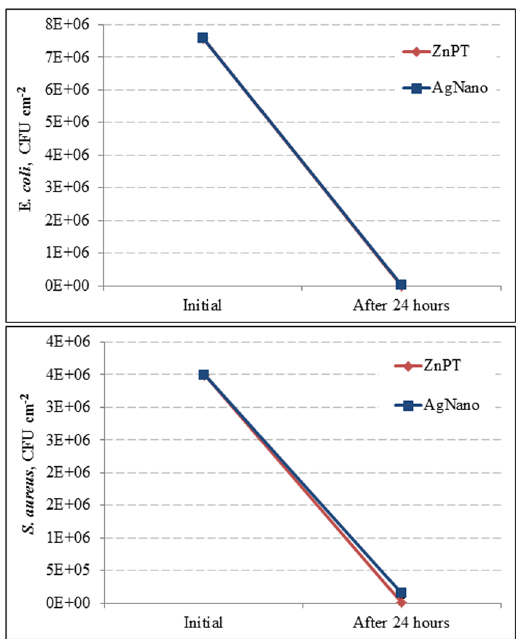
Figure 4. Variation in the number of colony forming units (CFU) of: (a) Escherichia coli and (b) Staphylococcus aureus population between the initial and final time in ZnPT and AgNano TPE incorporated